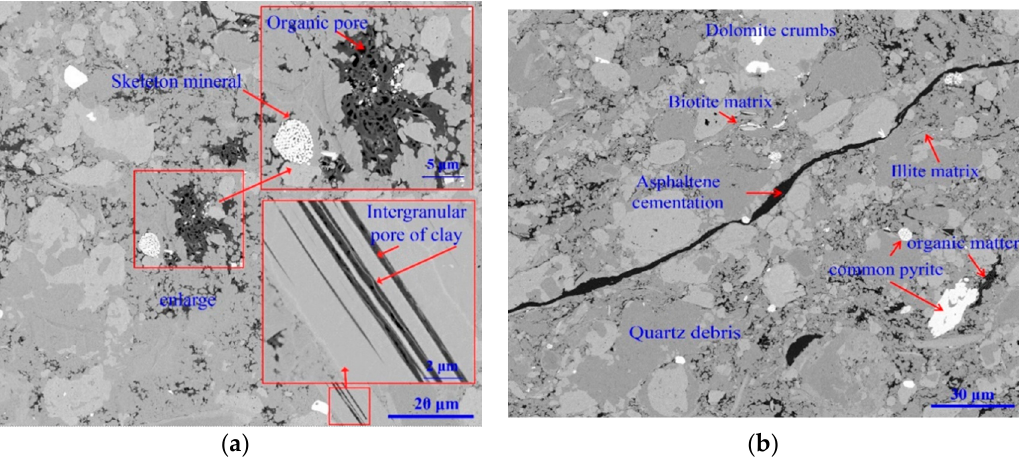
Figure 3. Scanning electron microscopy (SEM) images of Longmaxi shale. ( a ) The surface is parallel to bedding planes, and ( b ) the surface is perpendicular to bedding plane.